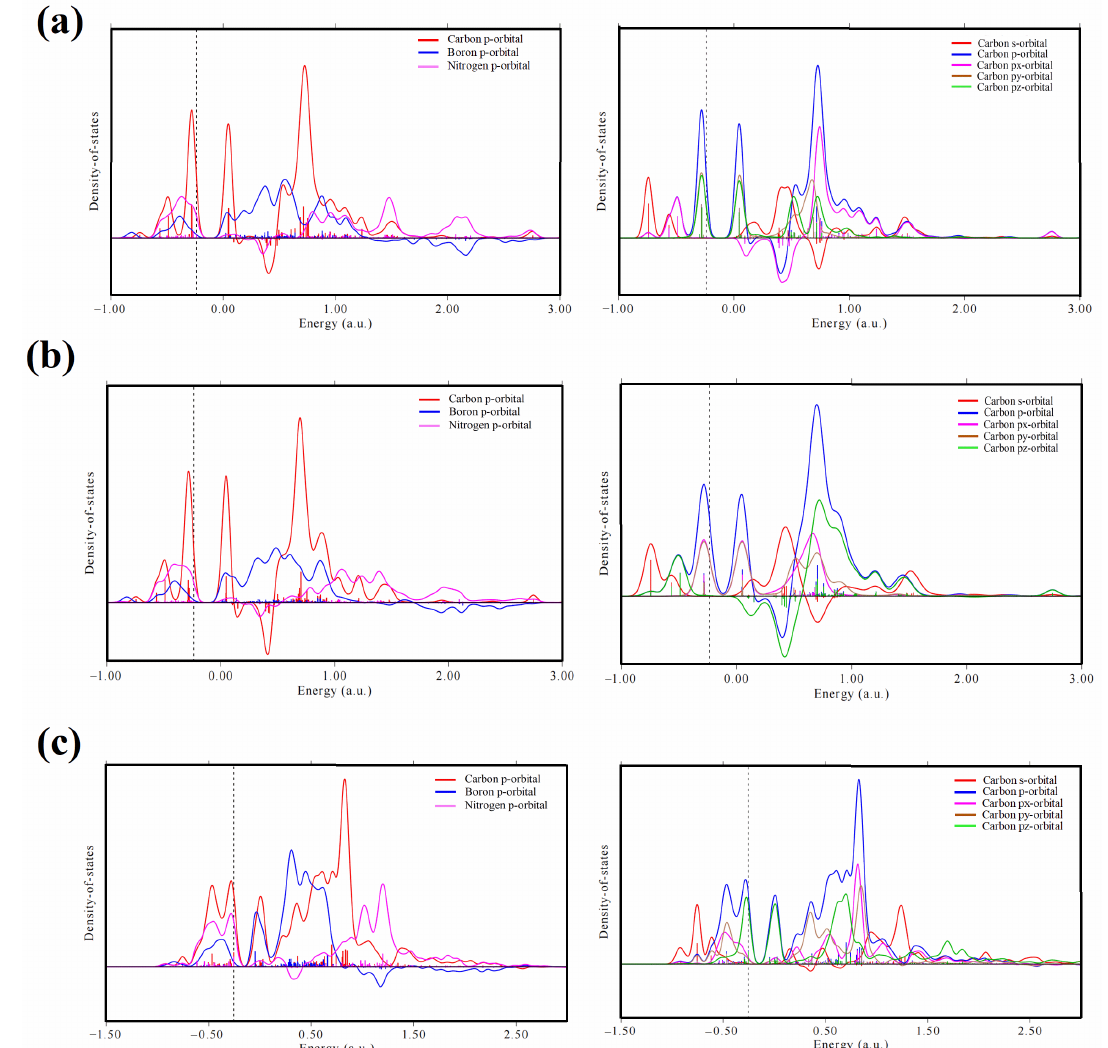
Figure 10. PDOS diagrams of acetylene adsorption structure on three different BN nanomaterials (( a ) left, ( b ) left, ( c ) left are DOS diagrams of C, B, and N atom p orbitals in an acetylene single adsorption structure on BNNS, BNNT, and B 12 N 12 NC, respectively; ( a ) right, ( b ) right, ( c ) right are DOS diagrams of different C 1 and C 2 atom orbitals in an acetylene single adsorption structure on BNNS, BNNT, and B 12 N 12 NC, respectively).